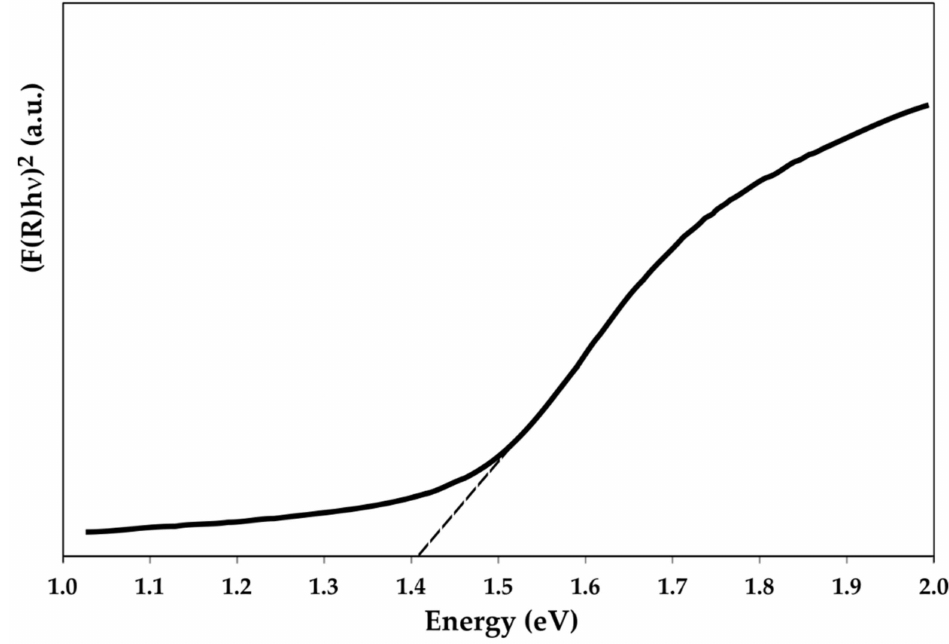
Figure 8. Tauc plot for the CuSbS 2 compound directly produced by mechanochemical